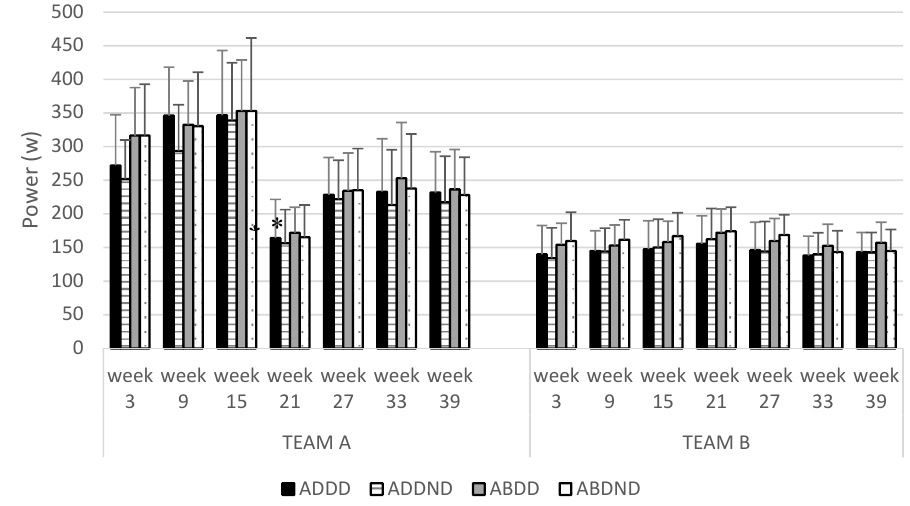
Figure 3. Mean power output of adductor and abductor exercises during the season. ADDD: Adductor dominant leg; ADDND: Adductor non-dominant leg; ABDD: Abductor dominant leg; ABDND: Abductor non-dominant leg (*) Significant differences with the last measure.